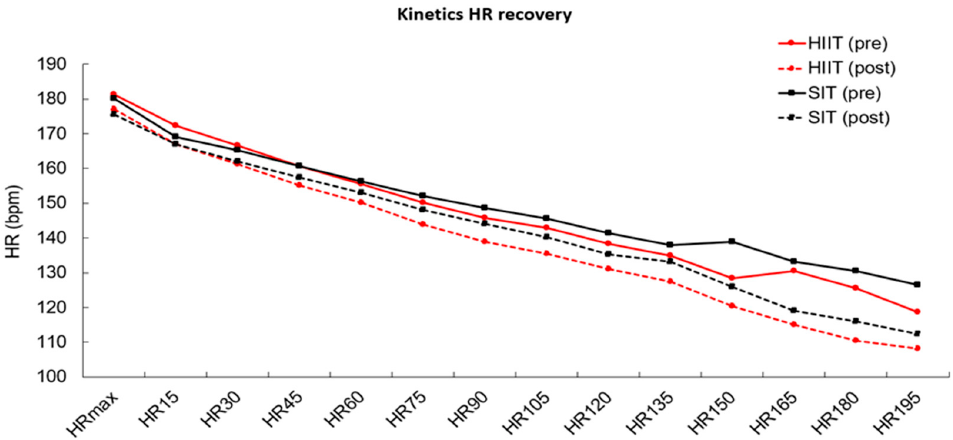
Figure 3. Kinetics of heart rate (HR) recovery after maximal graded exercise test before and after eight weeks of high intensity interval training (HIIT) or sprint interval training (SIT).